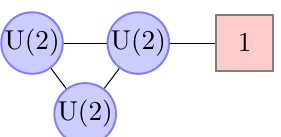
Figure 3 . The quiver diagram describing the mirror of the S 1 reduction of